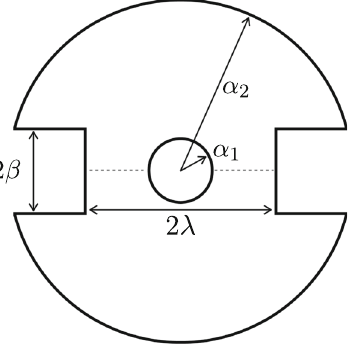
Fig. 9 2D projection at the Galactic center of the integration region A defined in the J -factor